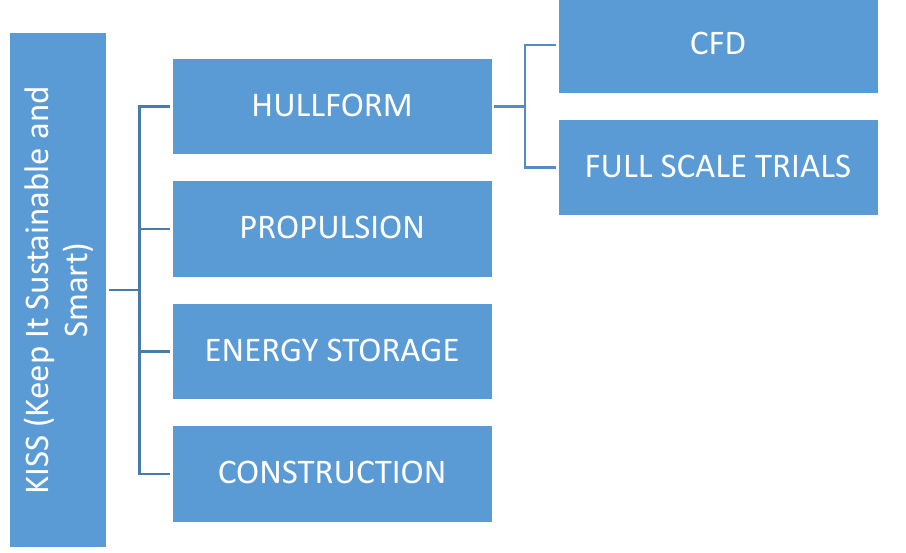
Figure 2. The main steps of the KISS program’s development.